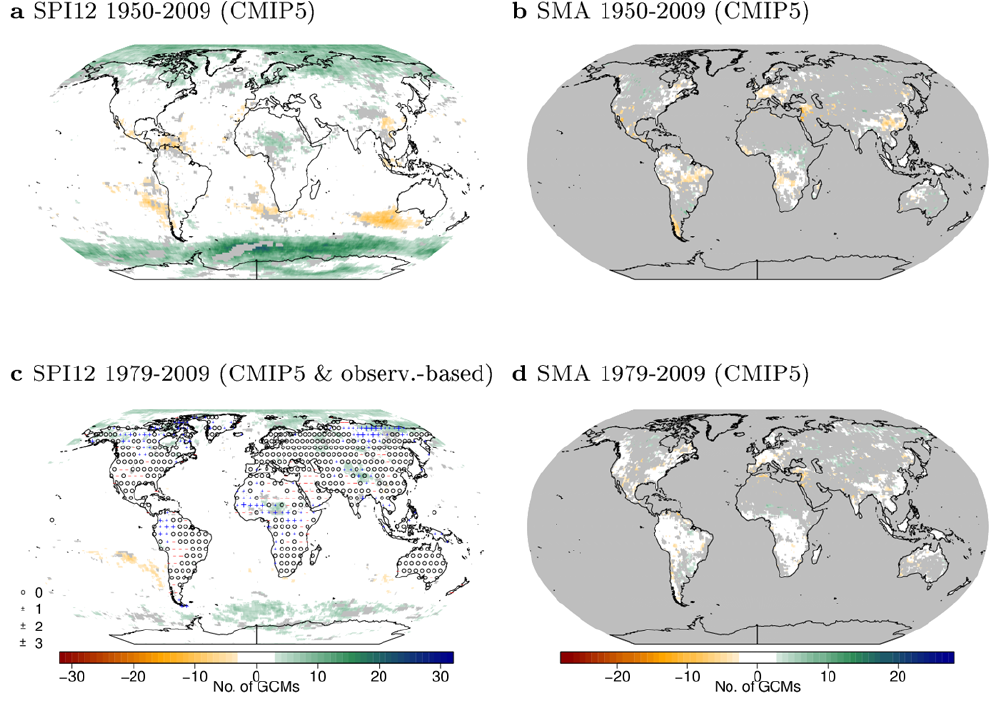
Fig. 2. Consistency of drought trends in two observational periods (observation-based datasets and CMIP5 GCM simulations) for SPI12 (a, c) and SMA (b, d) . Colour shading is applied if the significant trends (evaluated at the 0.5% significance level) across the CMIP5 ensemble are all of the same sign and indicates the number of GCMs with significant trends (green-blue for positive/wetting, orange-red for negative/drying trends). White indicates regions where at least 90% of the GCMs show no significant trends (consistently no change). All other areas are grey. Symbols in (c) show the same for three observation-based SPI12 datasets. “o”: none of the three datasets shows a significant trends; blue “ + ” and red “ − ” indicate purely significant positive/wetting and negative/drying trends, respectively; the size of the symbol indicates the number of agreeing observation-based datasets (see legend at c